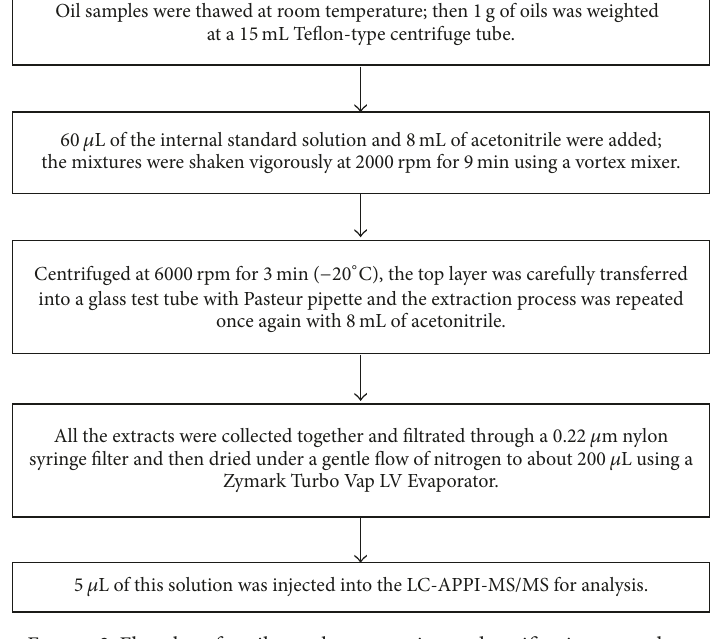
Figure 2: Flowchart for oil sample preparation and purification